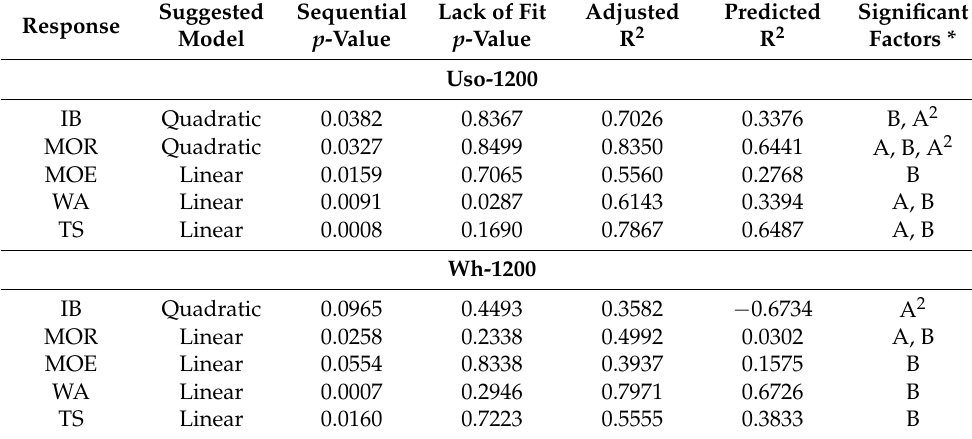
Table 4. Fit summary of the suggested models for each property of the boards with the density of 1200 kg m − 3